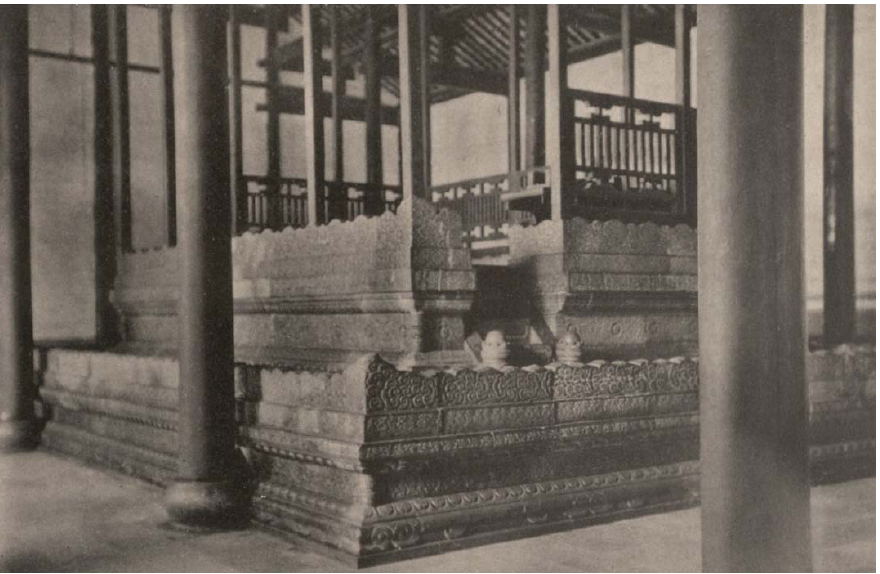
Figure 12. Photograph of the Ordination Platform (Prip ‐ Møller 1937, p. 243, Figure 270).